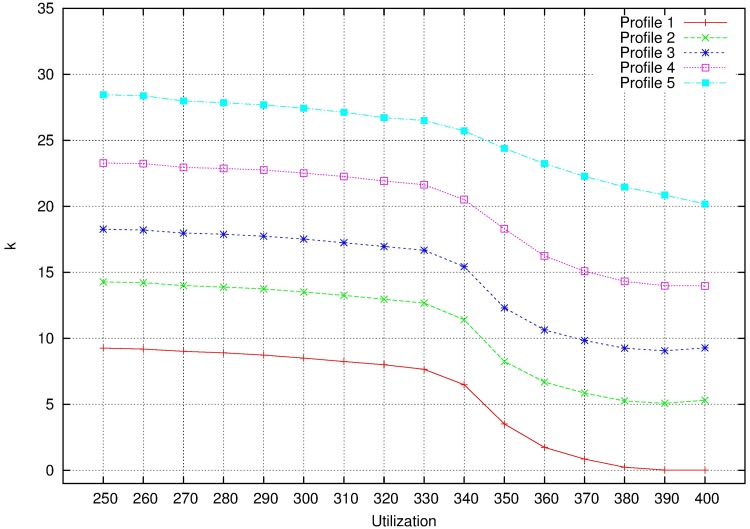
k for MCS profiles.